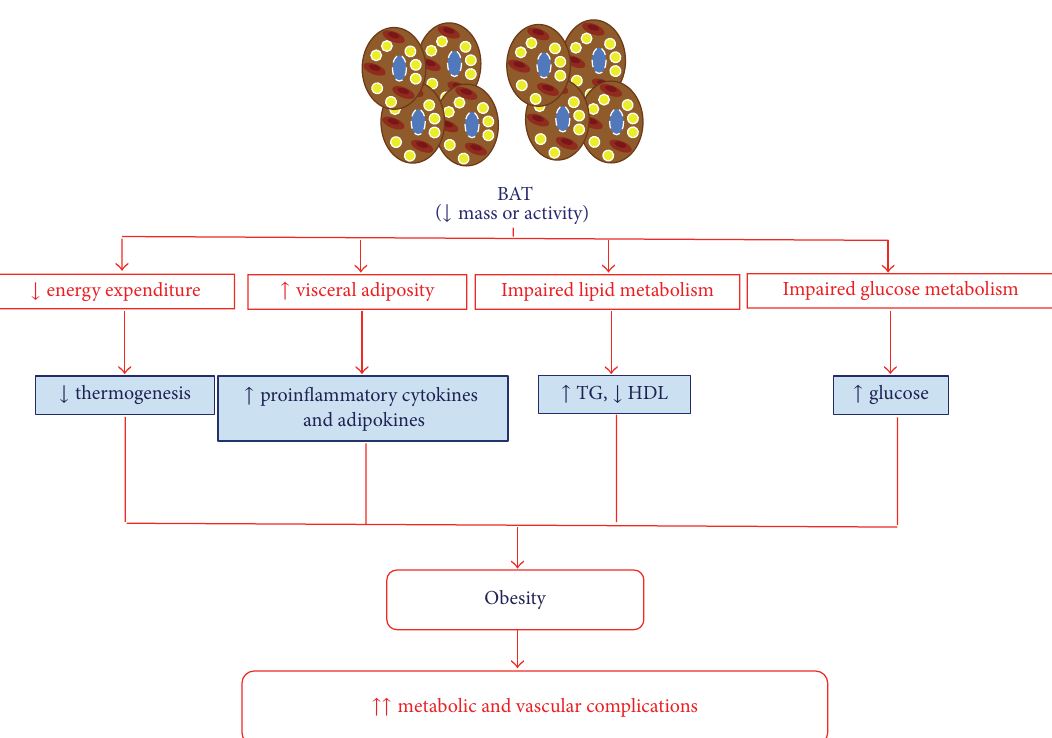
Figure 2: Contribution of brown adipose tissue to obesity and its associated metabolic and vascular complications. One of the possible causes that induce the development of obesity could be a decrease in the amount and activity of the brown adipose tissue. In this situation, there would be an alteration of functions that perform brown adipose tissue on lipid metabolism and carbohydrate as well as the expression profile of cytokines and adipokines, favoring obesity and the related metabolic and vascular